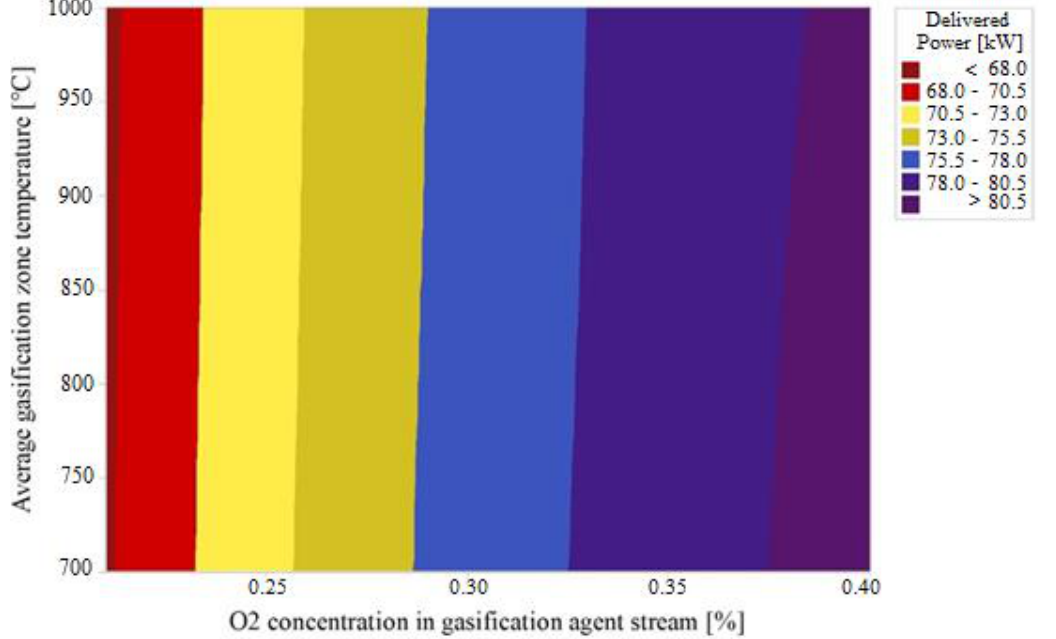
Figure 11. Power delivered by gas microturbine as a function of both the gasification temperature and the oxygen content in enriched air.